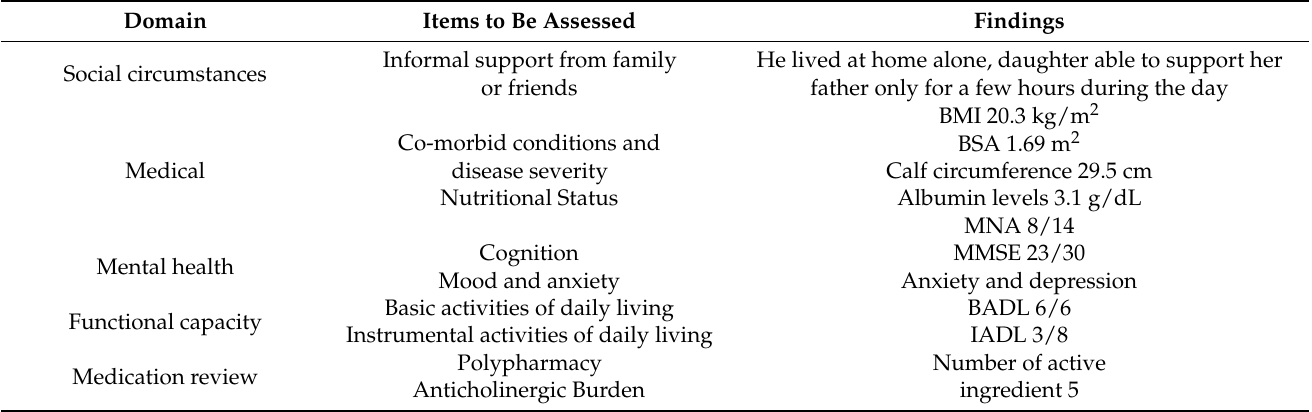
Table 1. The CGA of the clinical case. We suggest paying great attention to social support: A poor social network can lead to an overestimation of the real patient’s independence. Moreover, BMI is not sufficient to assess nutritional